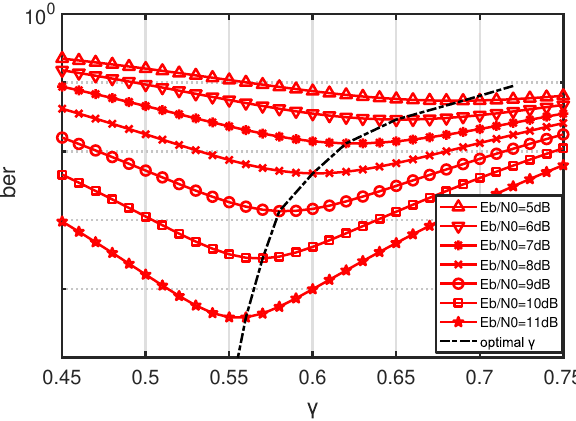
Figure 4. BER of 8-ary noncoherent PPM suboptimal receiver vs. γ